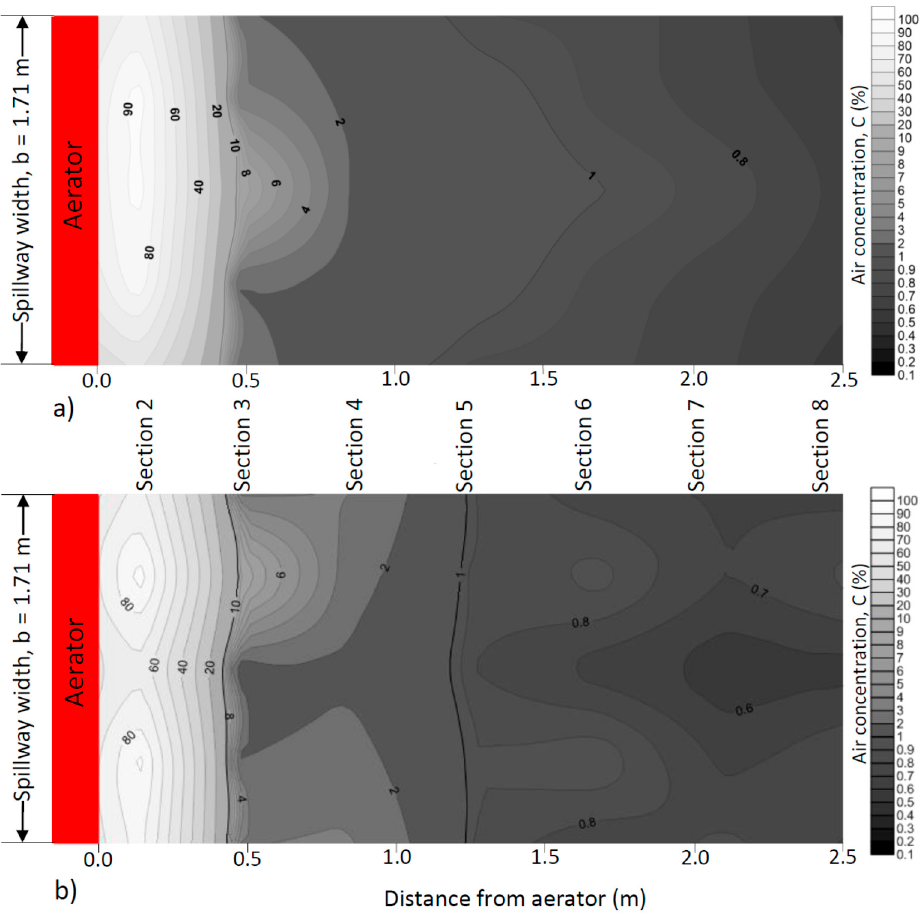
Figure 11. Bottom air concentration distribution for Q = 1500 L/s ( a ) spillway without pier, ( b ) spillway with pier.